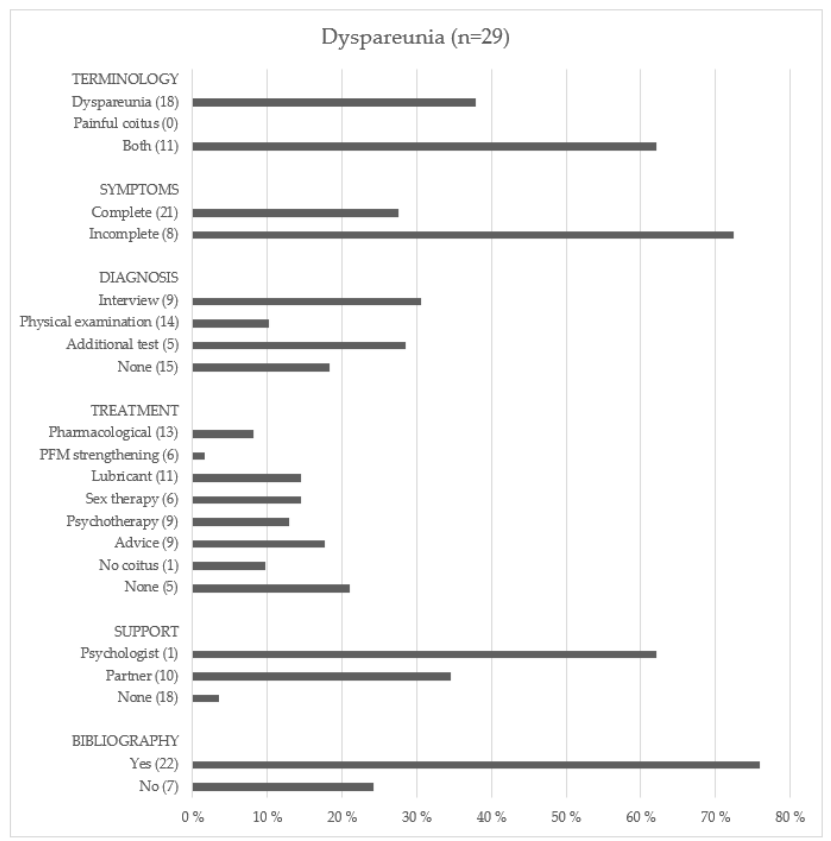
Figure 2. The type of information in websites on